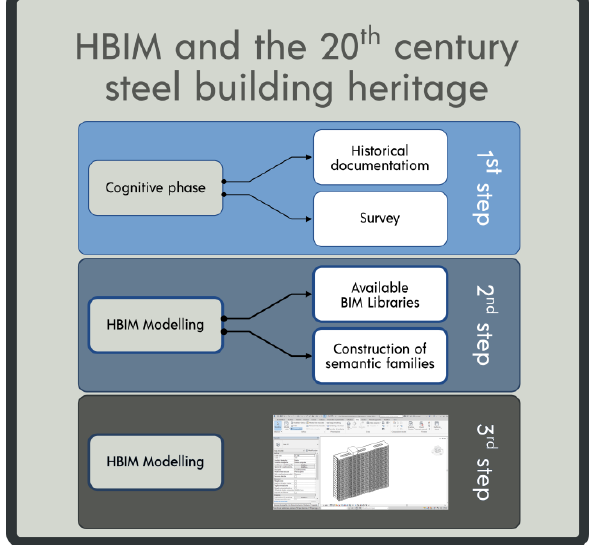
Figure 1: Framework of the BIM process for the architectural heritage made in steel.